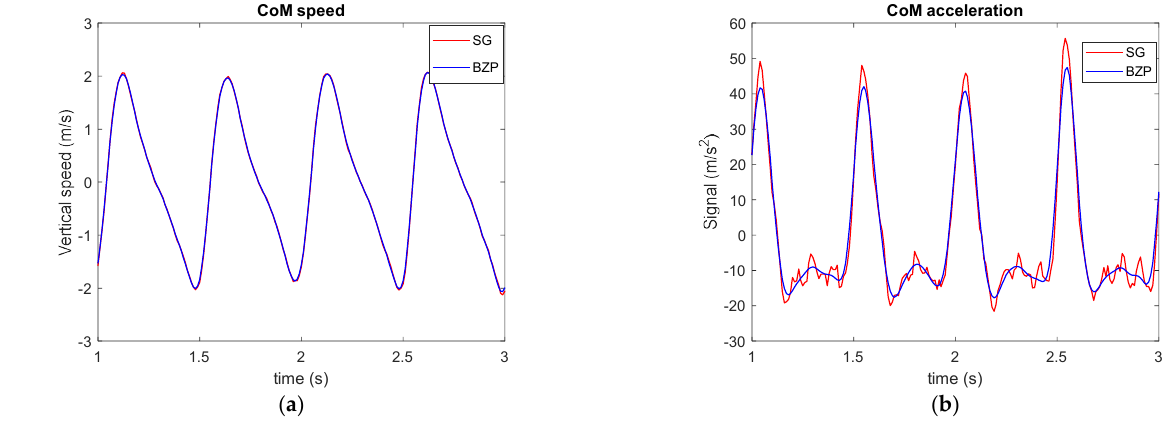
Figure 8. CoM vertical speed ( a ) and acceleration ( b ).